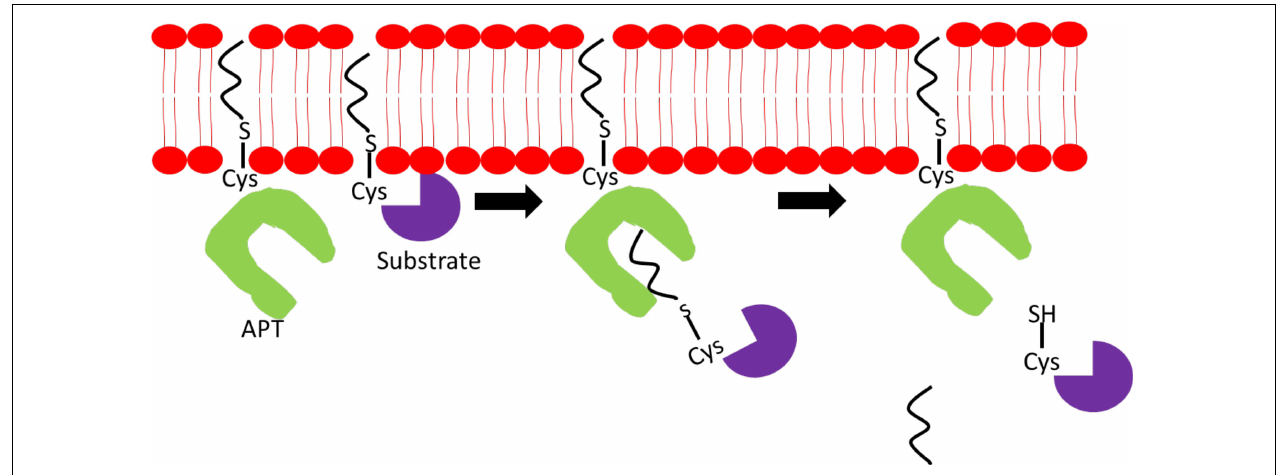
FIGURE 2 | Mechanism of action of acyl-protein thioesterase (APT). APT binds to a specific acylated substrate and cleaves off the fatty acyl chain located on the sulfur atom on the cysteine residue linked via thioester